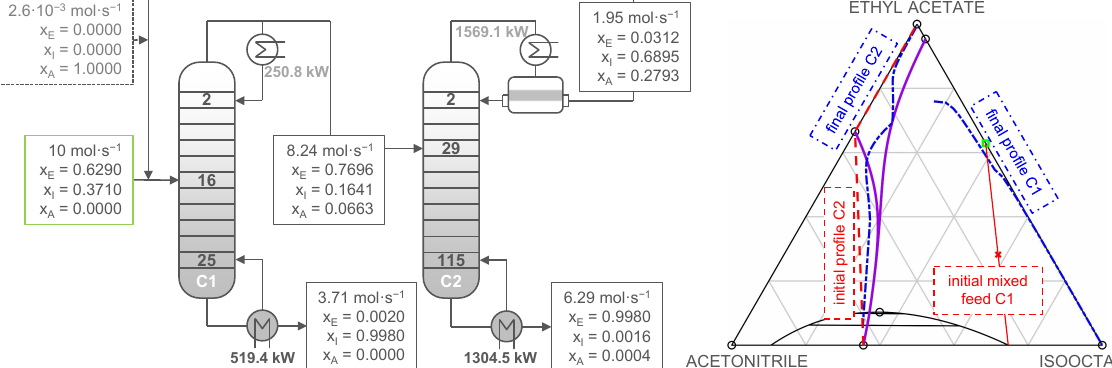
Figure 8. Optimal process design for the separation of ethyl acetate and isooctane using water as a solvent in a two-column heteroazeotropic distillation setup ( left ), including the initial and final liquid composition profiles of both columns in the corresponding Gibbs diagram ( right ). The initial composition profiles of columns C1 and C2 are plotted as red cross and dashed line, respectively, while the final composition profiles of both columns are plotted as blue dot-dashed lines. The feed composition is indicated by a green square and all singular points as well as the liquid-liquid critical point are marked as black